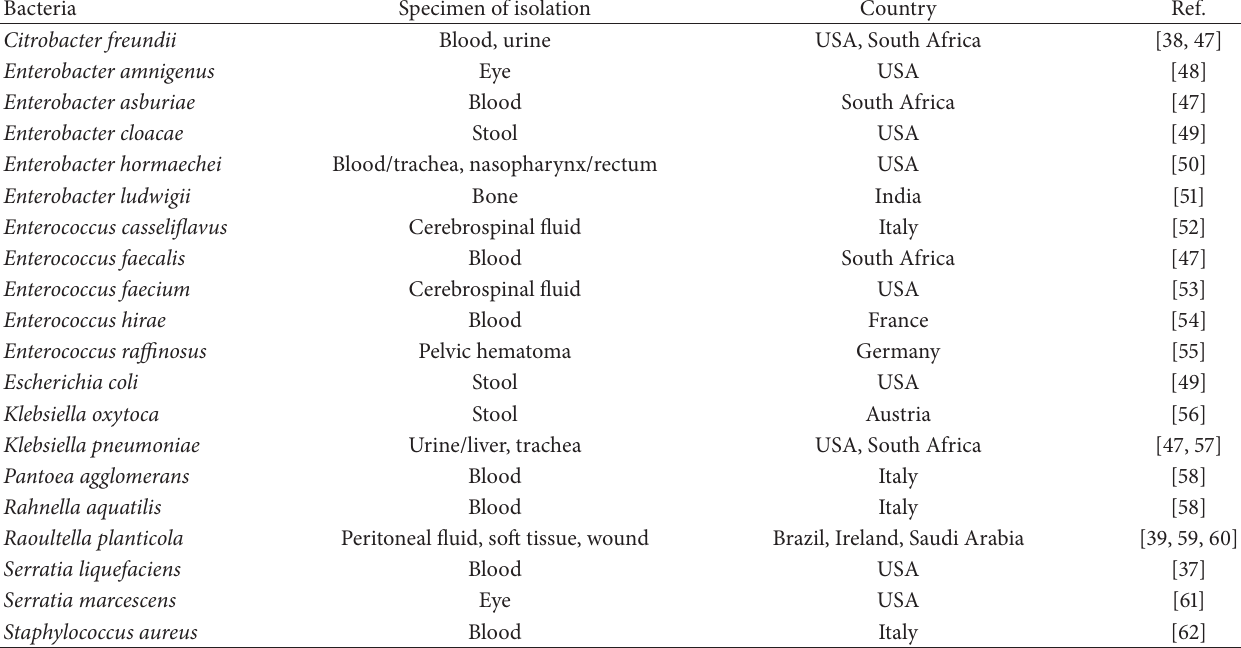
Table 4: Case reports for bacterial infections caused by bacteria listed in Table 2 as presented in the literature.